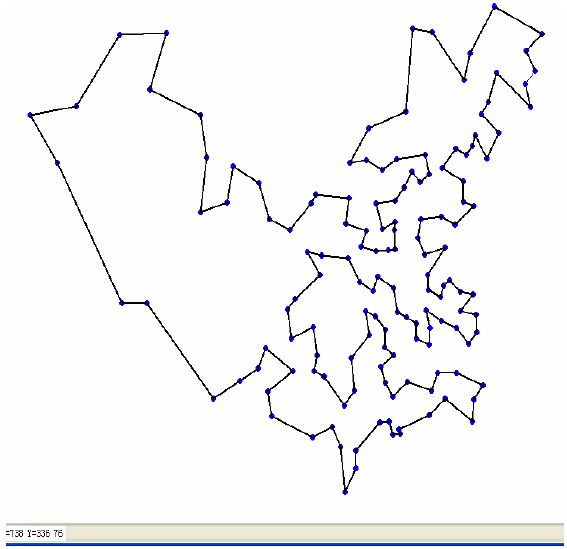
Figure 5.The best result of TSP benchmark instances Chn144